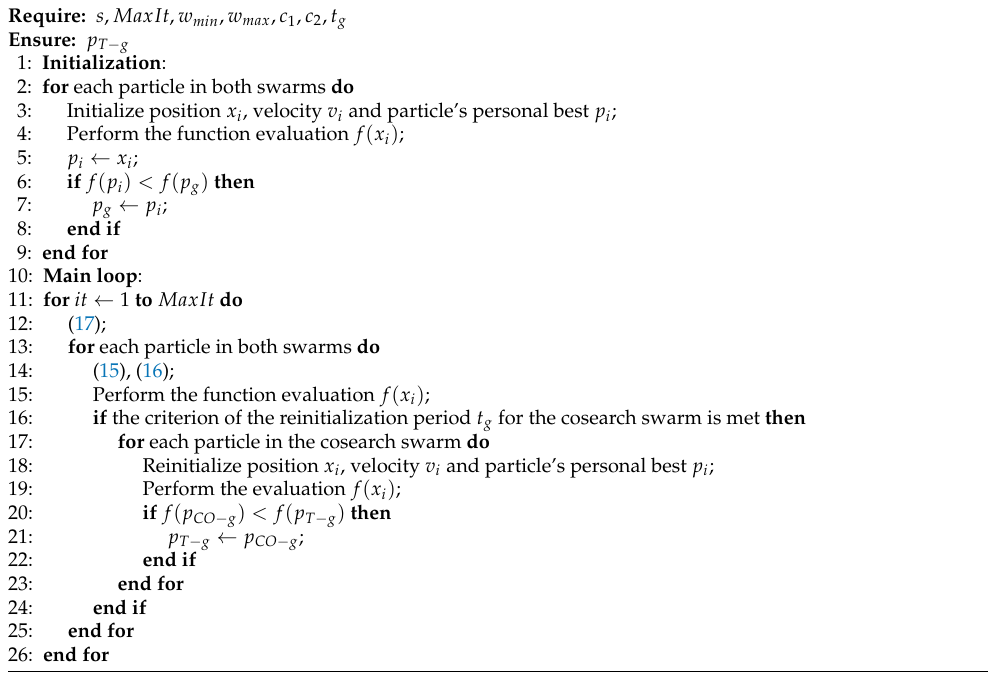
Algorithm A2 EPS-PSO algorithm-general